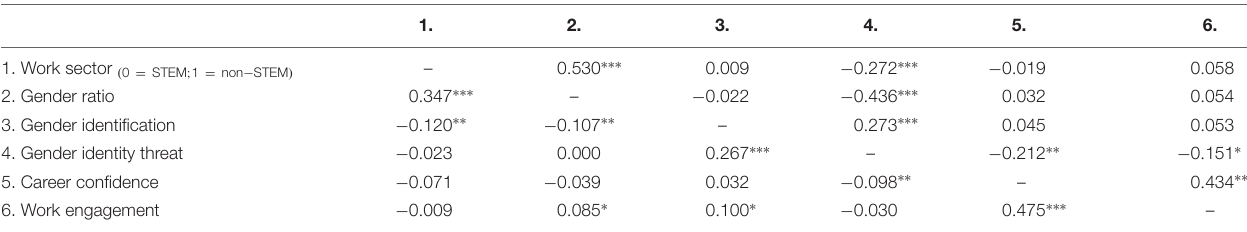
TABLE 2 | Correlations between model variables separately for gender